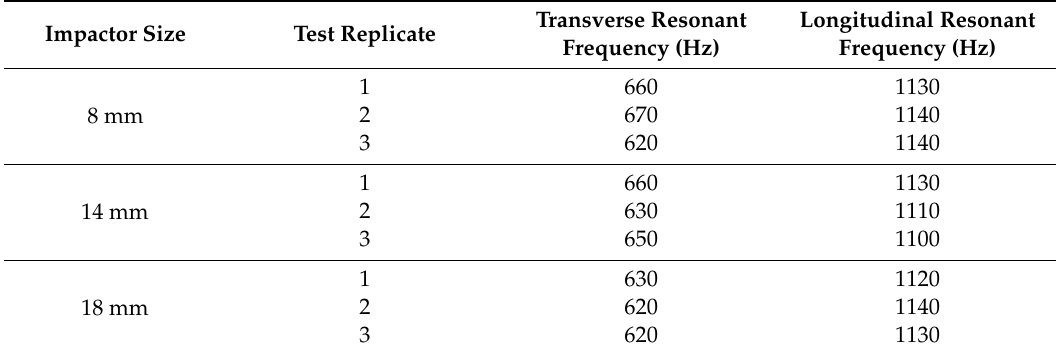
Table 9. Longitudinal and transverse resonant frequencies for the unmodified clay.